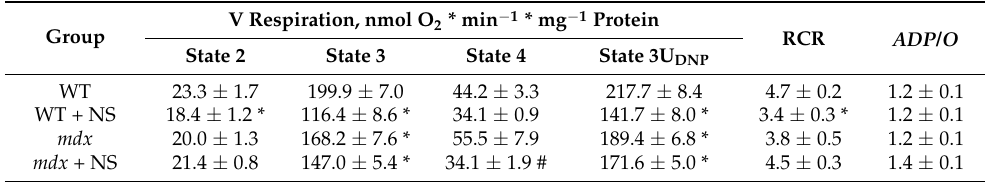
Table 2. The effect of NS1619 on the parameters of respiration and OXPHOS of the skeletal muscle mitochondria of the studied groups of mice. Group